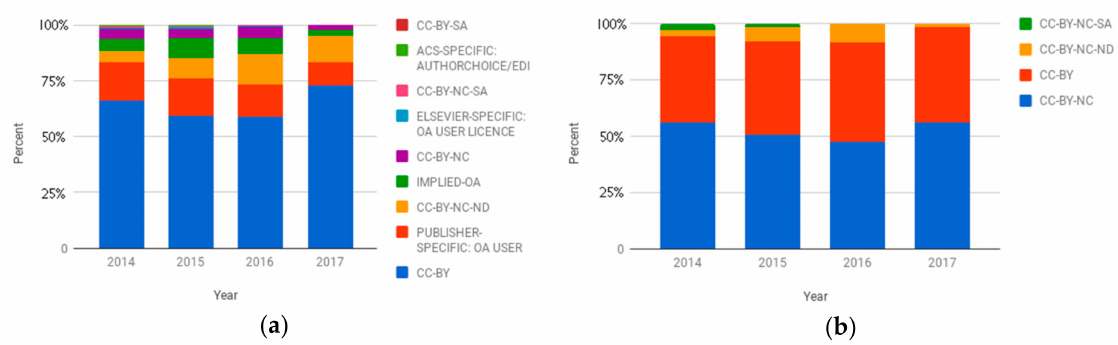
Figure 4. Unpaywall: Licence adoption by publisher and repository host locations: ( a ) publisher licences; ( b ) repository licences.